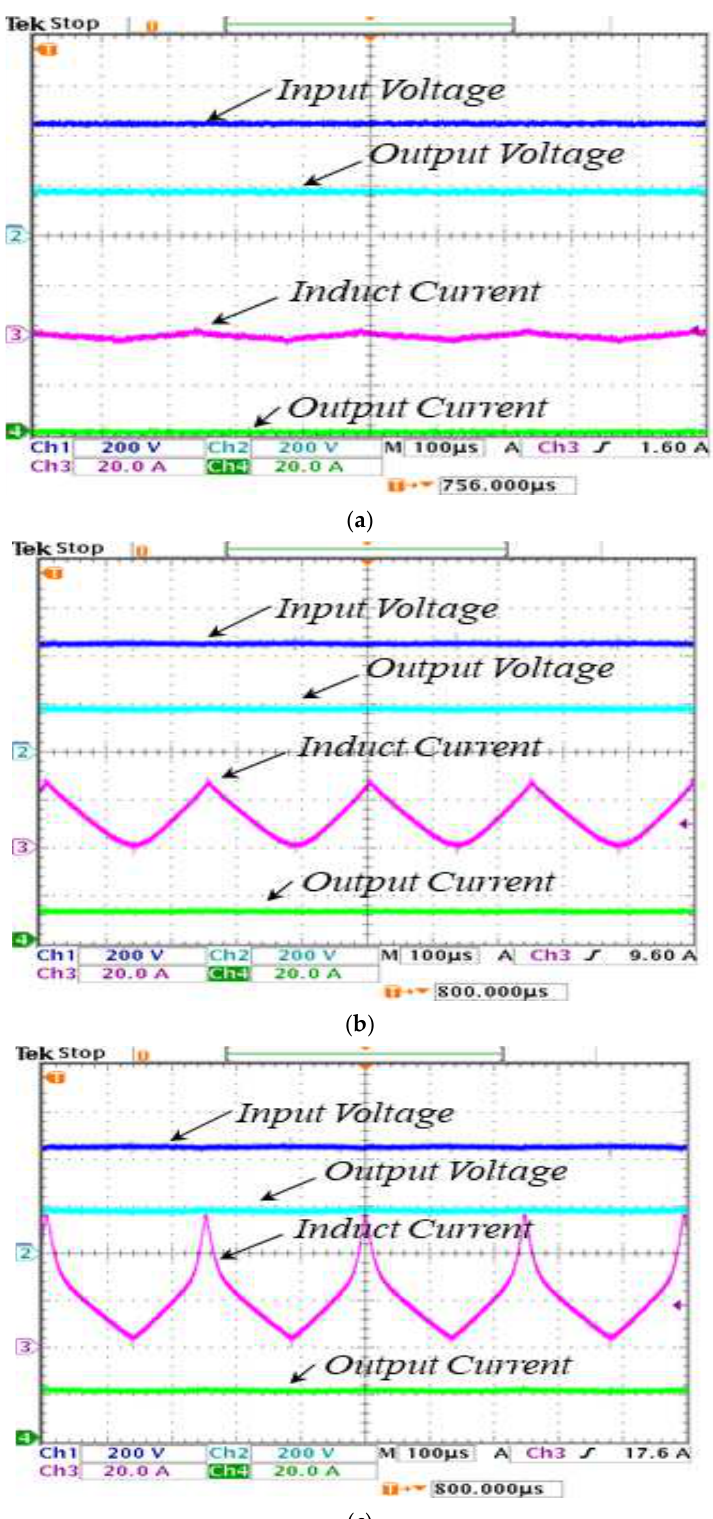
Figure 12. Analyze the characteristics of a heterogeneous reactor. ( a ): No-load condition. ( b ): 2 kW load. ( c ): 4 kW